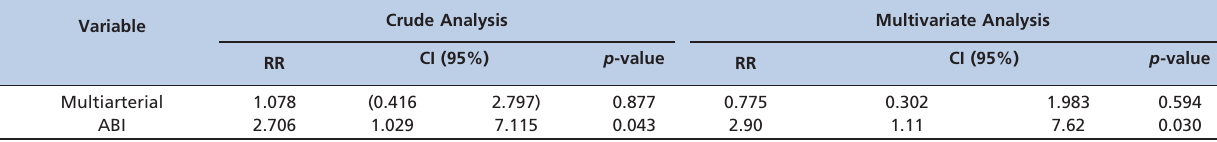
Table 4 - MACE analysis adjusting for confounding factors (ABI and multiarterial coronary disease). Variable